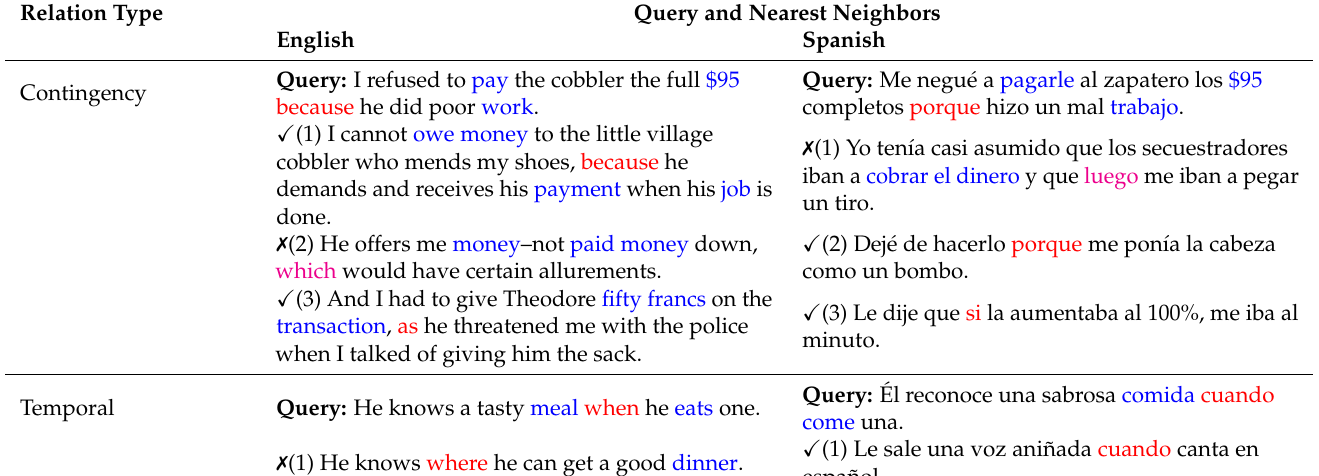
Table 4. Sentences retrieved from an unannotated corpus given an annotated query with discourse relations. Words highlighted in red and blue show discursive connectors and semantic relationships, respectively.